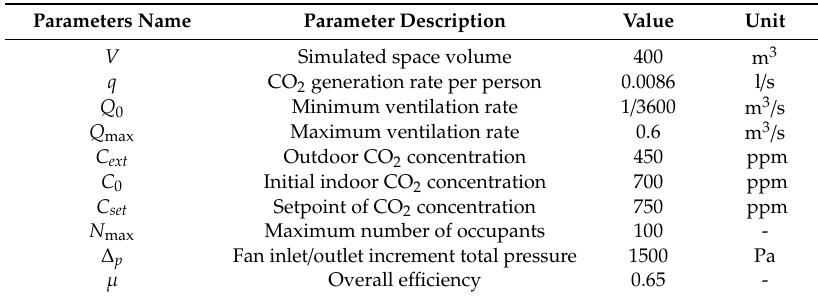
Table 2. Settings of the ventilation system model parameters.